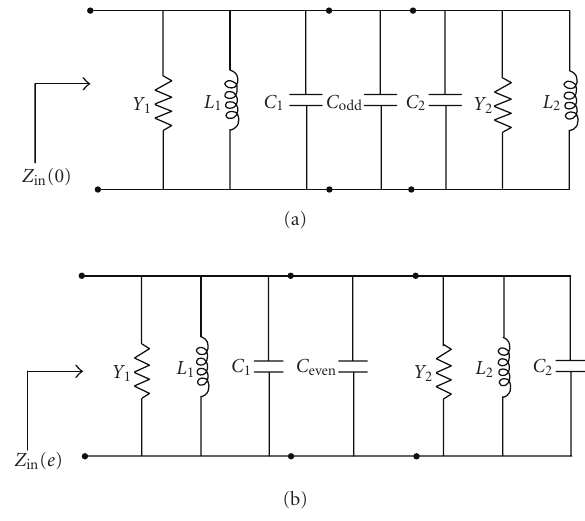
Figure 3: (a) Modified equivalent circuit of gap-coupled ARMSA for odd mode. (b) Modified equivalent circuit of gap-coupled ARMSA for even mode.